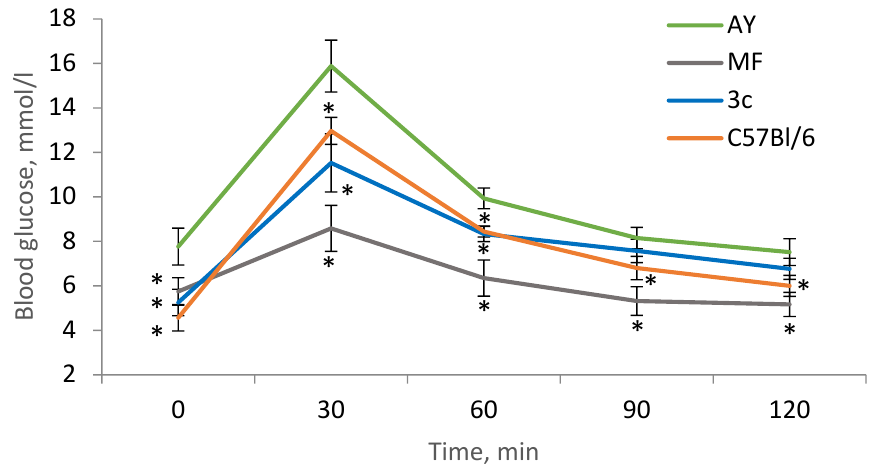
Figure 3. The results of the OGTT performed after 2 weeks of AY mice treatment by compound 3c at a dose of 15 mg/kg. MF was introduced at a dose of 250 mg/kg. * p < 0.05 as compared to AY mice.